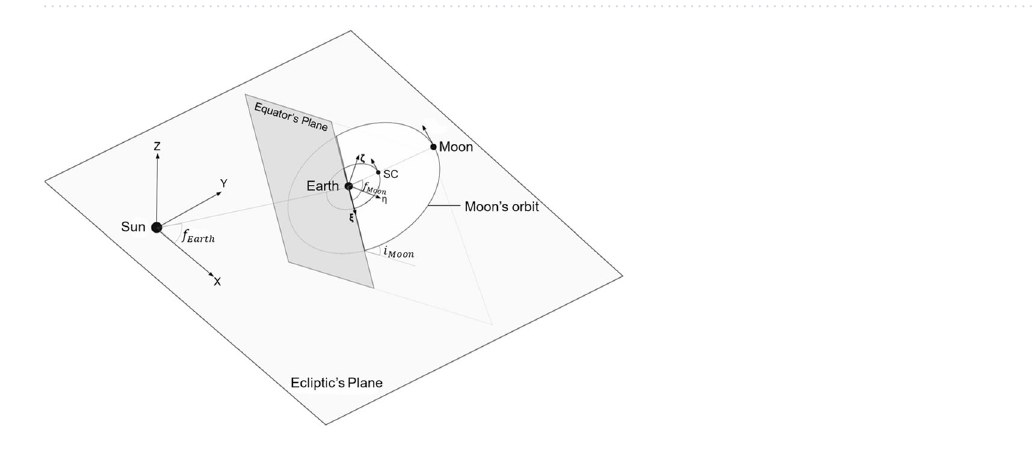
Figure 2. Relative positioning in the